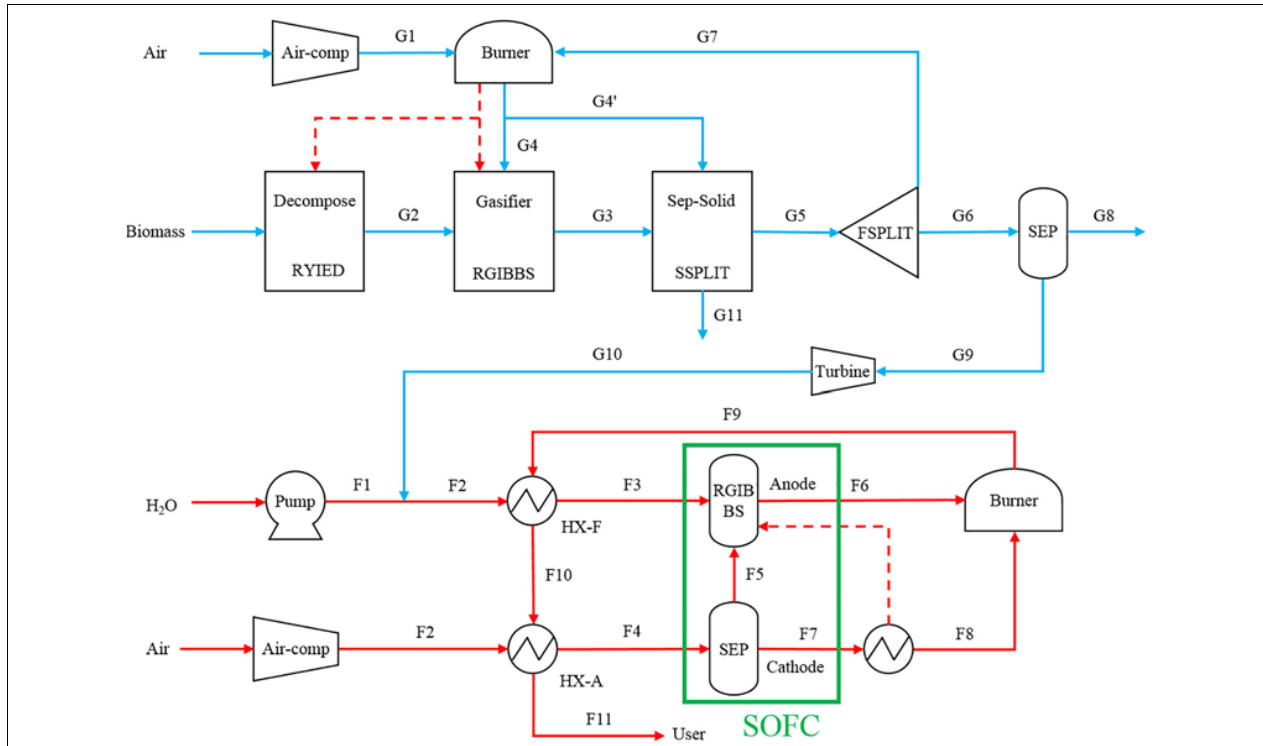
FIGURE 1 | BG-SOFC-CHP system flowchart. F, fuel; G, gas; HX, heat exchanger; SEP, separator; COMP, compressor; RGIBBS, Gibbs reactor.